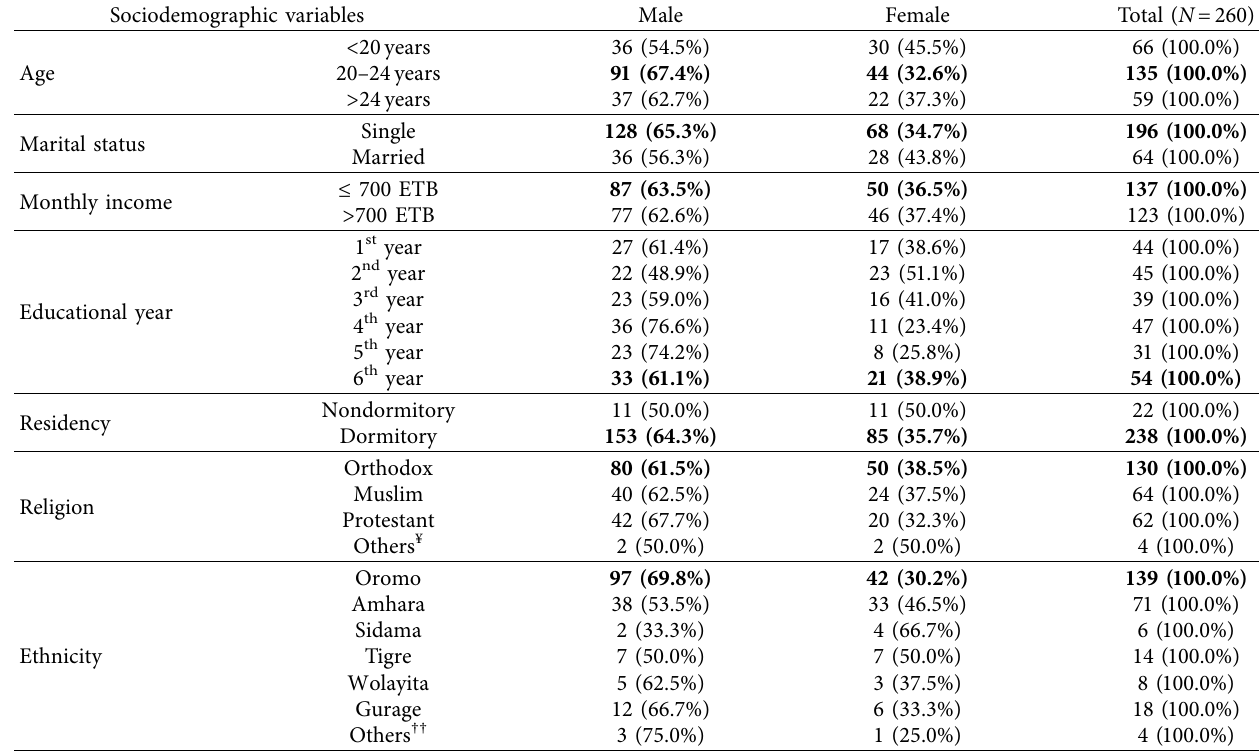
Table 1: Sociodemographic characteristics of study participants in relation to gender, AU, January 2019. Sociodemographic